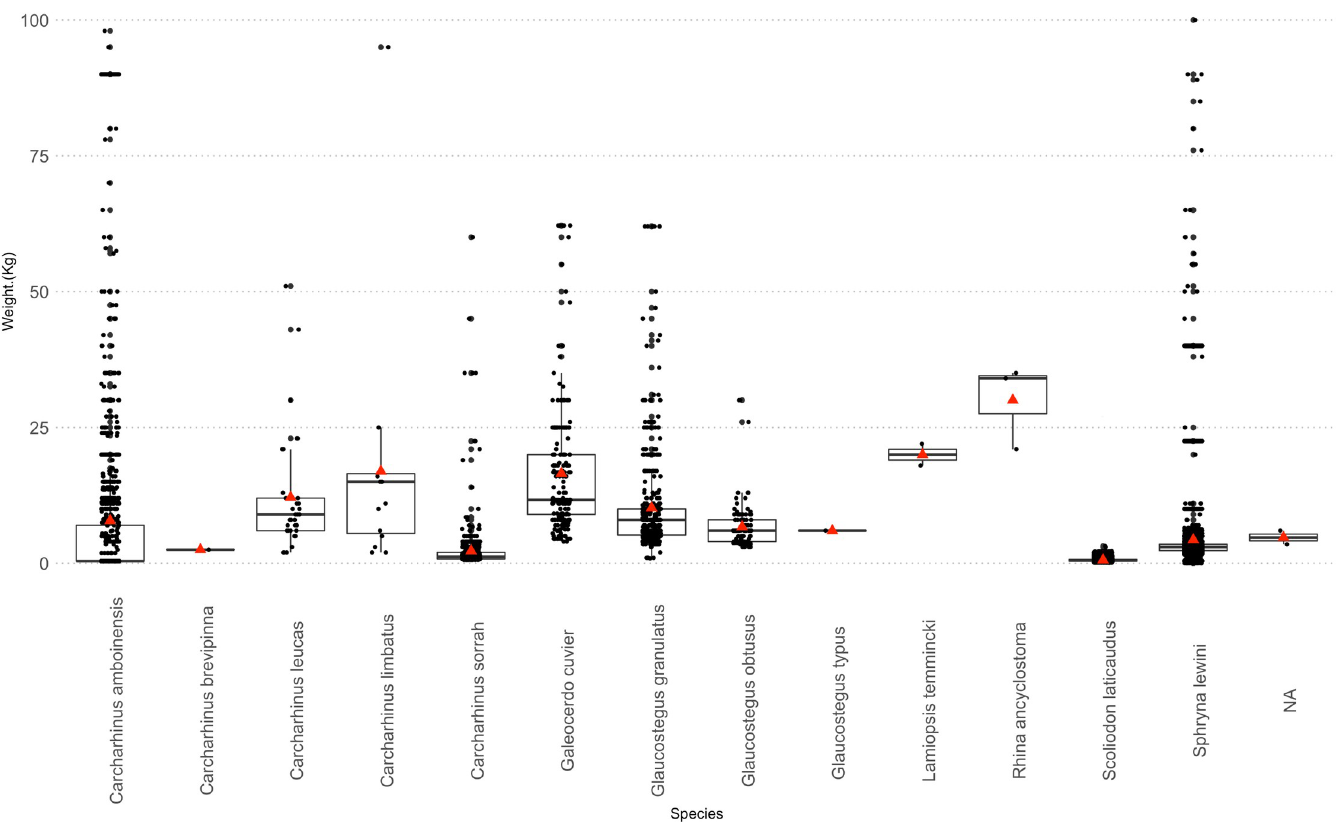
Fig 5. Range of weights of elasmobranch species landed during the study period with mean (red triangle). Weights of greater than 100 kg were mostly estimated hence are not shown in the figure. The weight range in kg for sampled specimens were as follows: C . amboinensis (0.4–450, mean = 9), C . brevipinna (2.5), C . leucas (2– 51, mean = 12.14), C . limbatus (2–95, mean = 26.44), C . sorrah (0.6–60, mean = 2.28), G . cuvier (4–62.14, mean = 16.54), G . granulatus (0.9–62, mean = 10.21), L . temmincki (18–22, mean = 20), S . laticaudus (0.09–2, mean = 0.604), S. lewini (0.4–200, mean = 4.38).